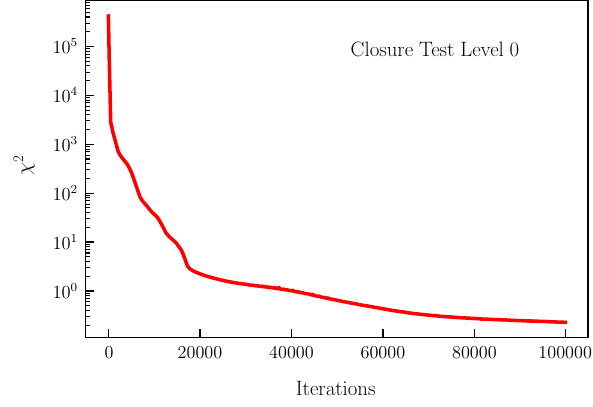
Fig. 7 Thevalueofthetotal χ 2 asafunctionofthenumberofiterations in a Level 0 minimization procedure. Only a single replica is shown, which represents a specific choice of the initial conditions of the fit